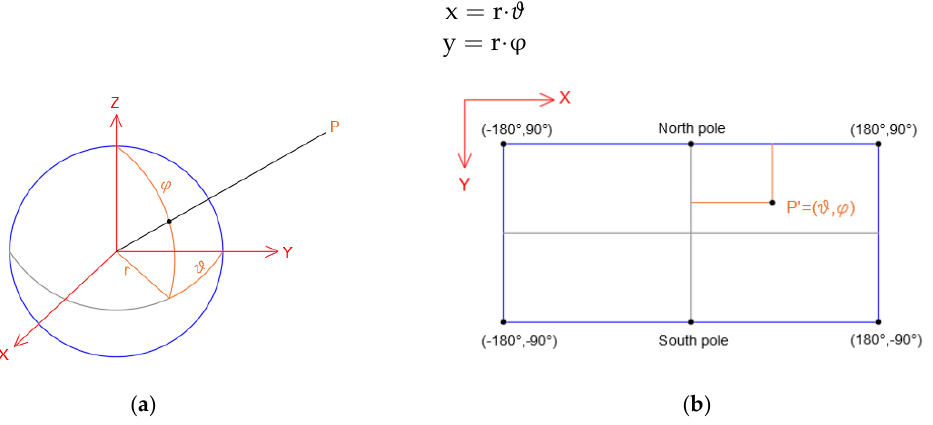
Figure 1. Relationship between spherical coordinates ( a ) and the image coordinate in the equirectangular image ( b ).